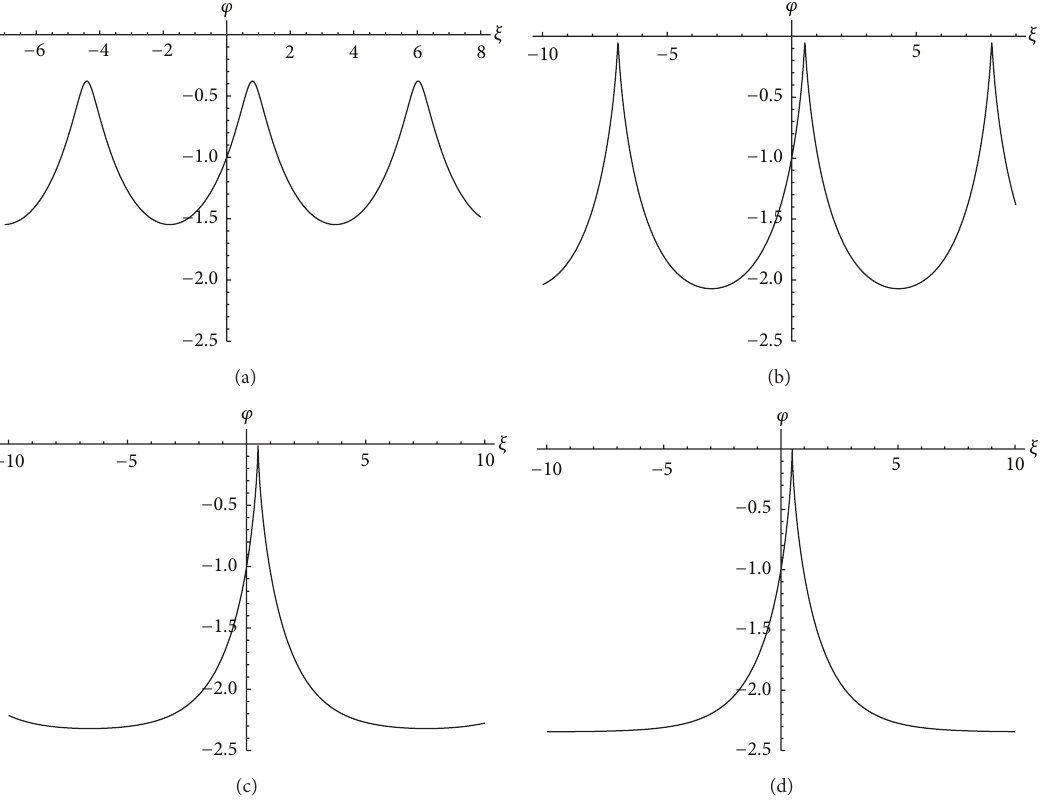
Figure 4: The simulations of periodic integral curves of (8) for Case 4, where the initial values (𝜑(0),𝜑 󸀠 (0)) = (−1,0.7), (−1,1.1), (−1,1.17), (−1, 1.170704)